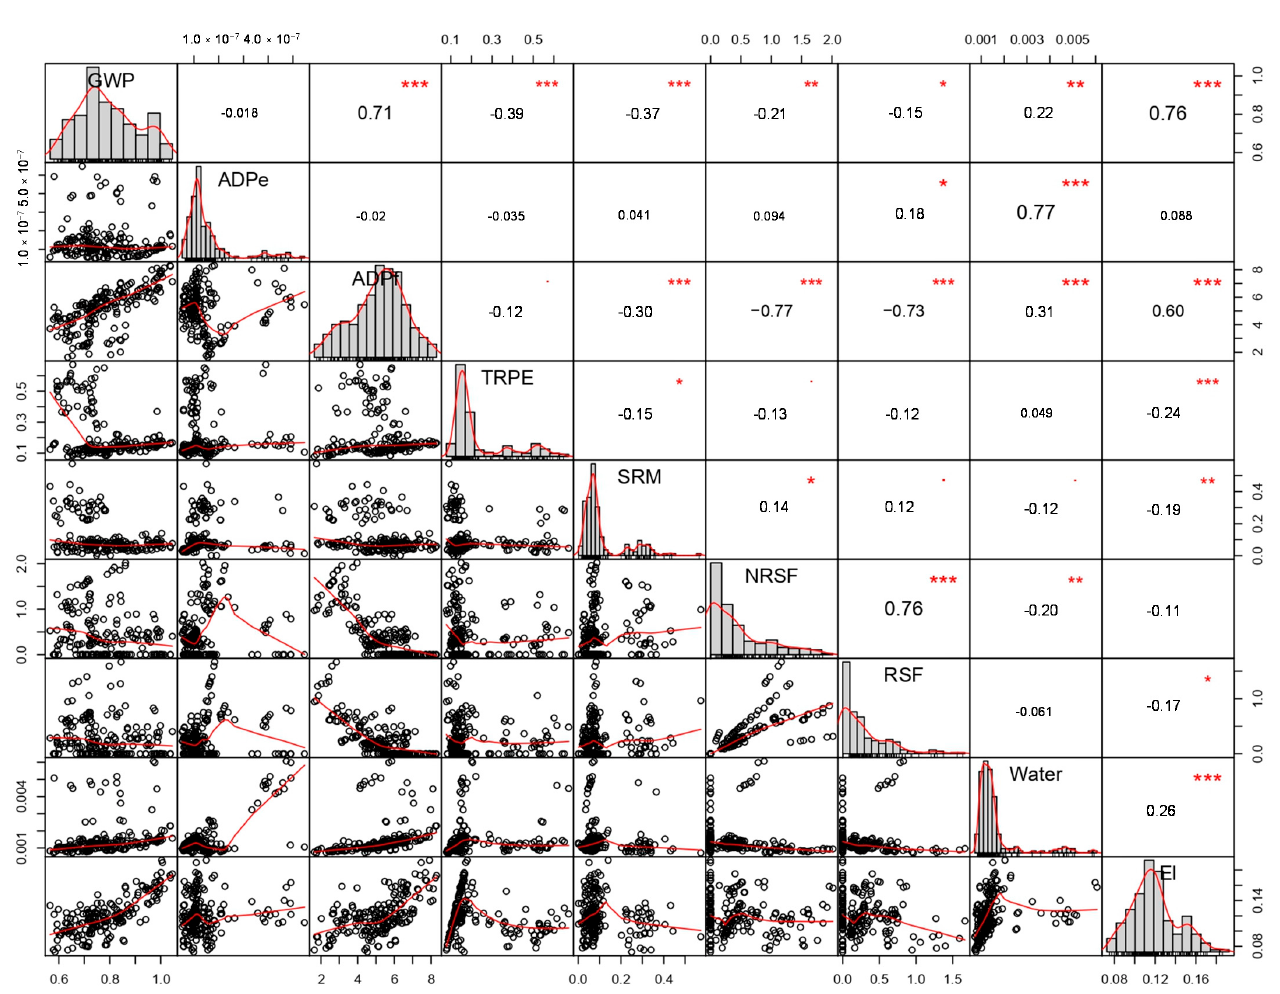
Figure 4. Correlation matrix analysis (GWP vs. Consumption ICs). “***” ( p -value ≤ 0.001), “**” ( p -value ≤ 0.01), “*” ( p -value ≤ 0.05), “.” ( p -value ≤ 0.1), and “ ” otherwise. This notation is valid throughout the article.